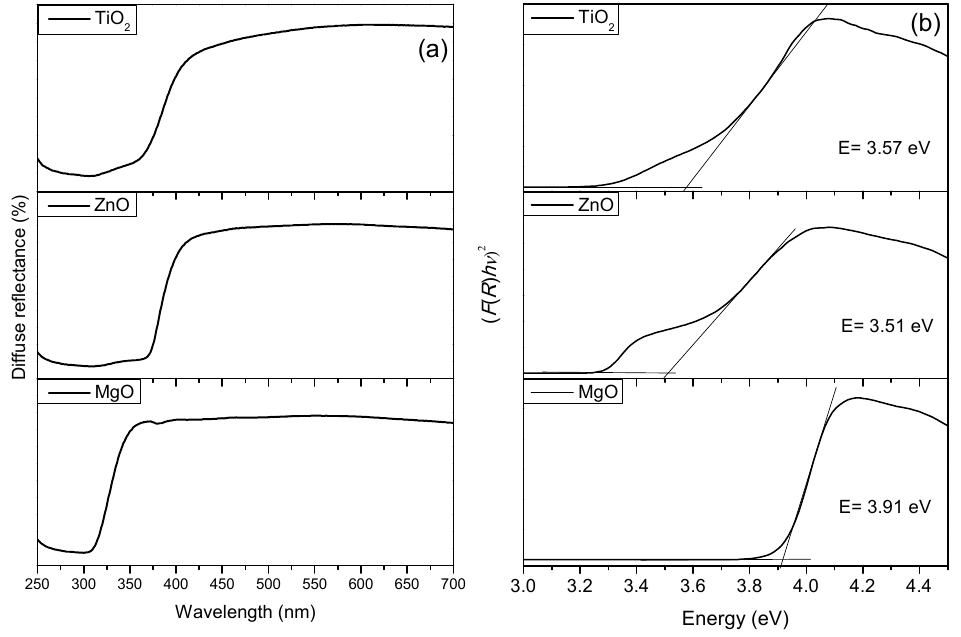
Figure 3. UV–Vis spectra ( a ) and band gap energies ( b ) of studied materials. The materials were degassed for 5 h at T = 100 ◦ C with Nova1200e apparatus and analyzed at 77 K with nitrogen. The BET method was used for evaluating the surface area, and BJH was used for pore size distribution. The total pore volume was obtained from the last point of adsorption branch from hysteresis near 1 P / P 0 . Adsorption–desorption isotherm obtained after performing the analysis was presented in Figure 4. In the inset of Figure 4, the average distribution of pores was shown. TiO 2 isotherm is of type IVa with hysteresis of type H2b, according to IUPAC classification [40]. In the case of a Type IVa isotherm, capillary condensation was accompanied by hysteresis. This occurs when the pore width exceeds a certain critical width, which is dependent of the adsorption system and temperature